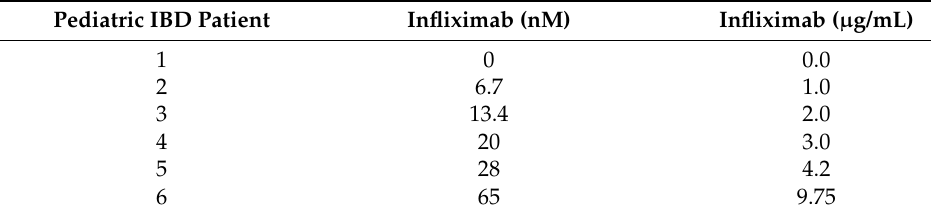
Table 2. ELISA measurements in the pediatric IBD cohort. Abbreviations: IBD, inflammatory bowel disease.